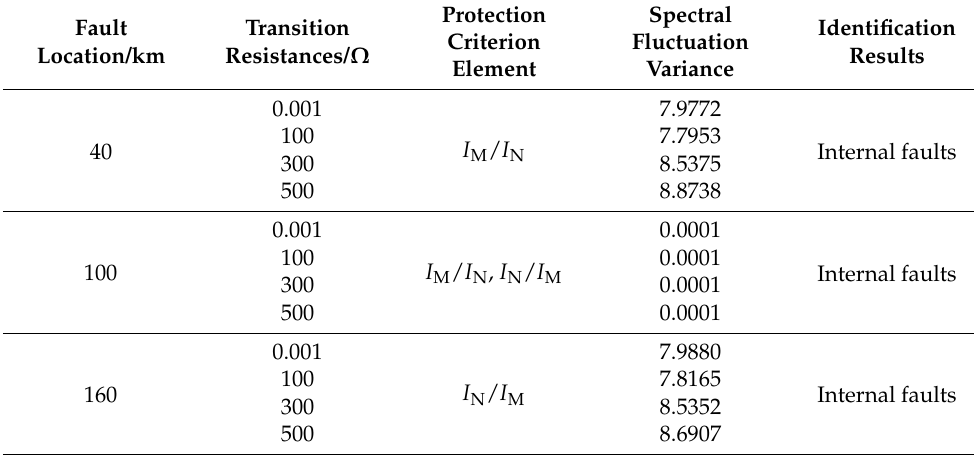
Table 5. Spectrum fluctuation variance in fault current ratio in the case of internal A-phase ground faults with different transition